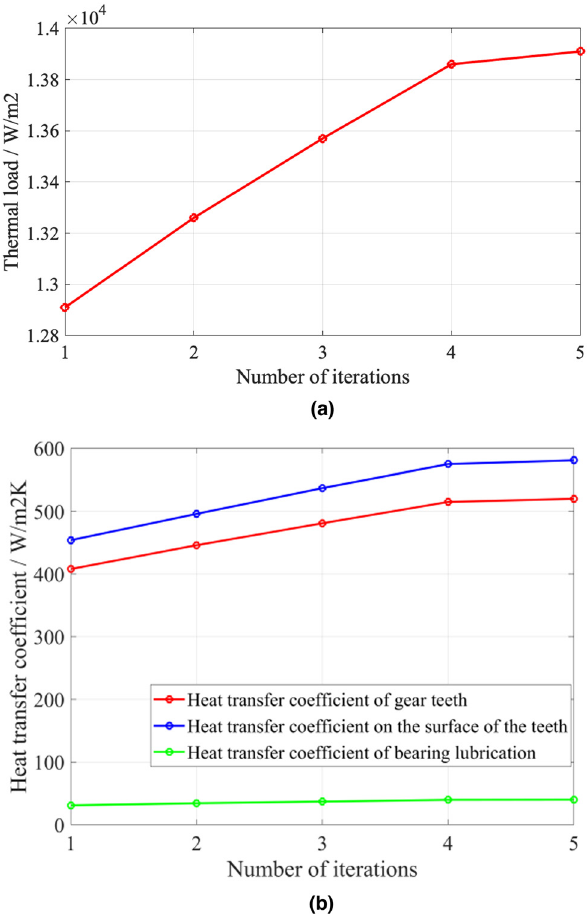
Figure 8: Data correction for each iteration. ( a ) Heat generated by teeth. ( b ) Heat transfer coe ffi